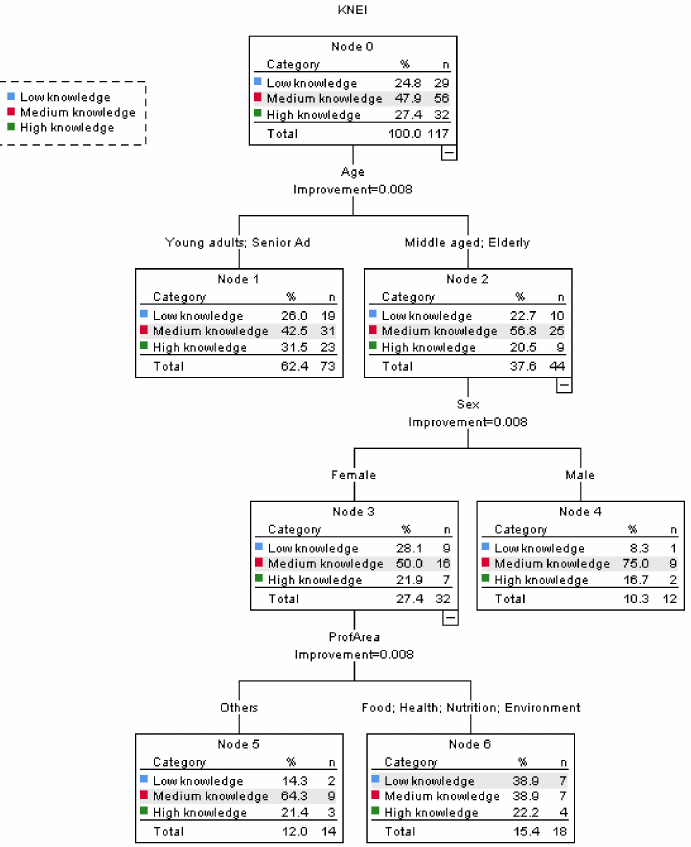
Figure 3. Tree classification for the influence of sociodemographic variables on the level of knowledge about nutritive properties of EI